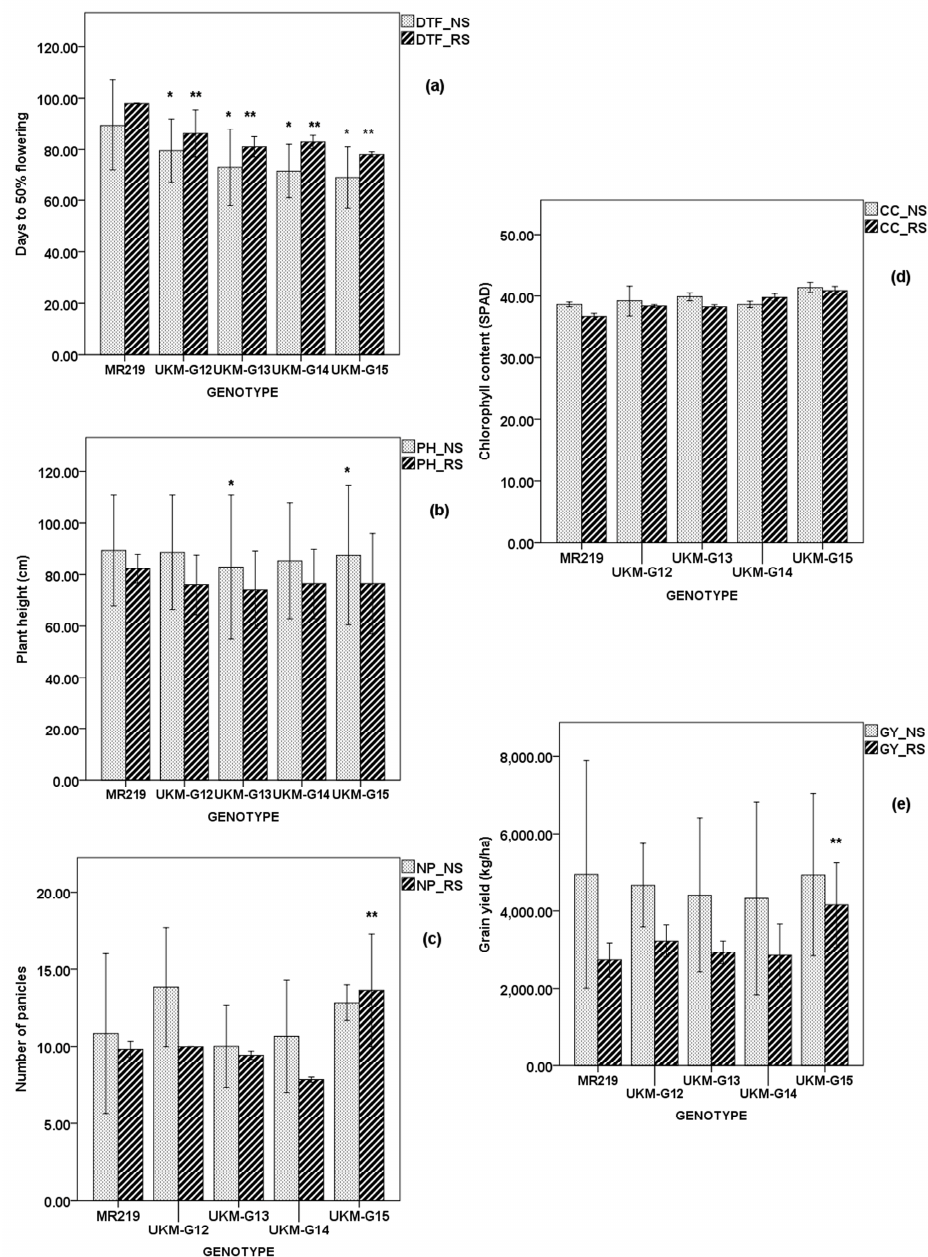
Figure 3. Average of mean of MR219 population for two seasons under NS and RS. ( a ) Days to 50% flowering, ( b ) Plant height (cm), ( c ) Number of panicles, ( d ) Chlorophyll content, ( e ) Grain yield (kg / ha). * Significant di ff erence from MR219 under NS; p < 0.05, ** Significant di ff erence from MR219 under RS; p < 0.05. Error bar: ± standard error (SE).